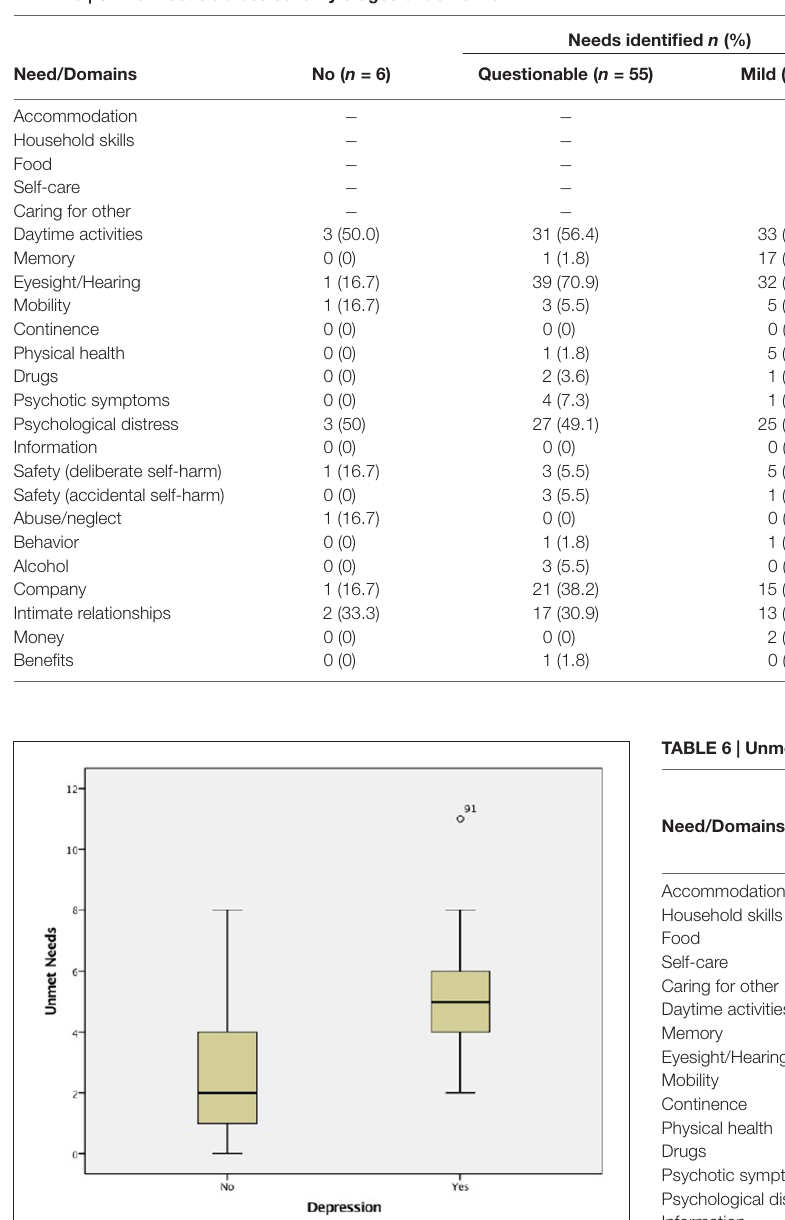
TABLE 5 | Unmet needs across severity stages of dementia .